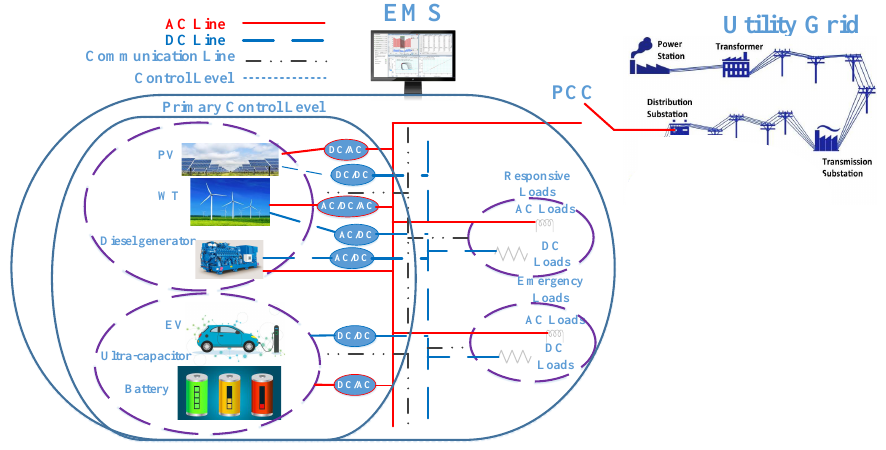
Figure 1. MG structure and